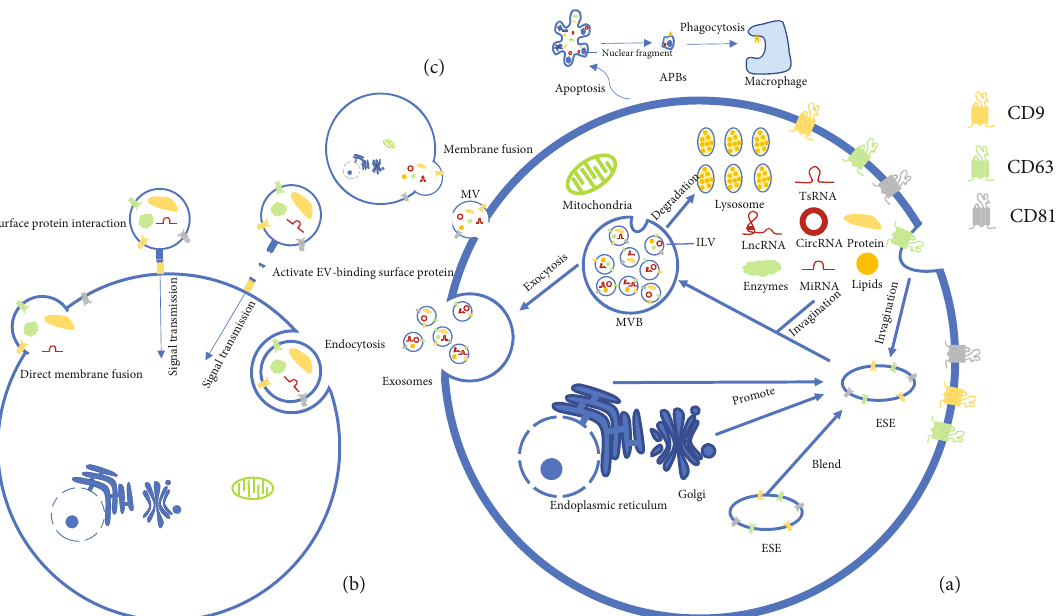
Figure 1: Biogenesis, secretion, and ingestion of EVs. (a) Exosomes from ILV in MVBs are secreted outside cells by exocytosis, transporting lipids, lncRNA, miRNA, circRNA, proteins, tsRNA, and enzymes between cells. CD63 is a de fi ning exosome transmembrane protein. (b) Exosomes act in multiple ways on receptor cells. (c) Origin and secretion of MV and APBs. Key: APBs: apoptotic bodies; ESE: early- sorting endosome; ILV: intraluminal vesicles; MV: microvesicles; MVB: multivesicular bodies; tsRNA: tRNA-derived small